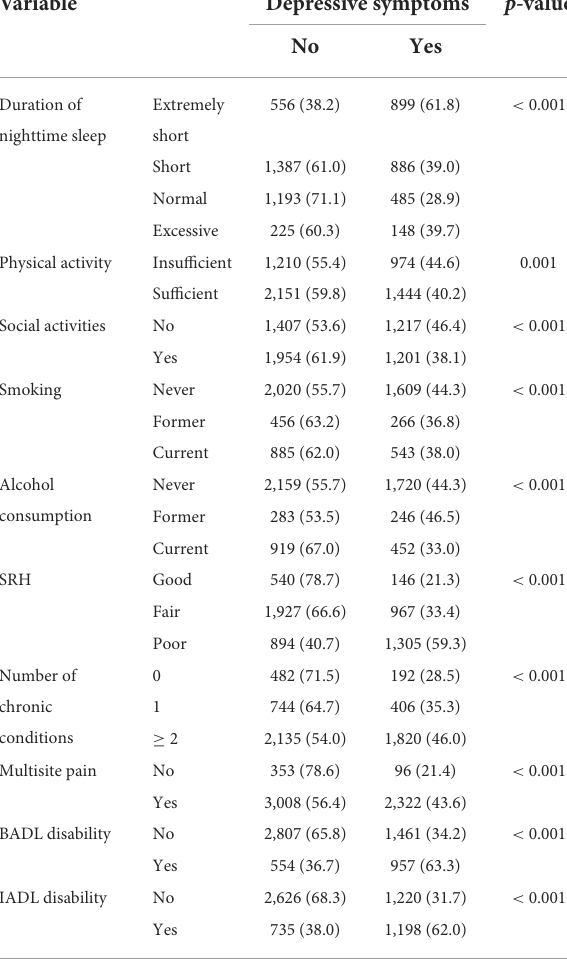
TABLE 2 Health-related characteristics of the LBP population by the presence of depressive symptoms ( n = 5,779). Variable